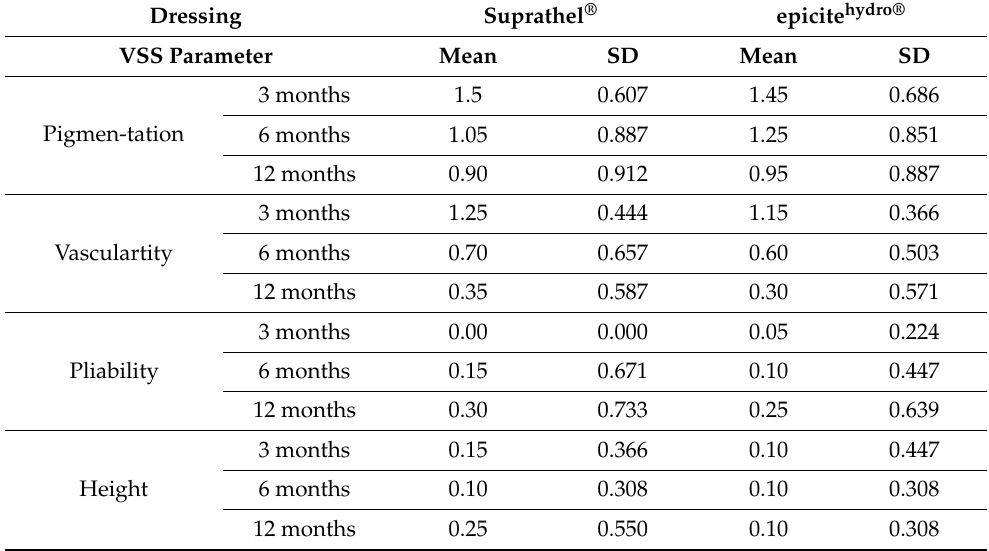
Table 5. Results of the Vancouver Scar Scale in mean and SD (standard